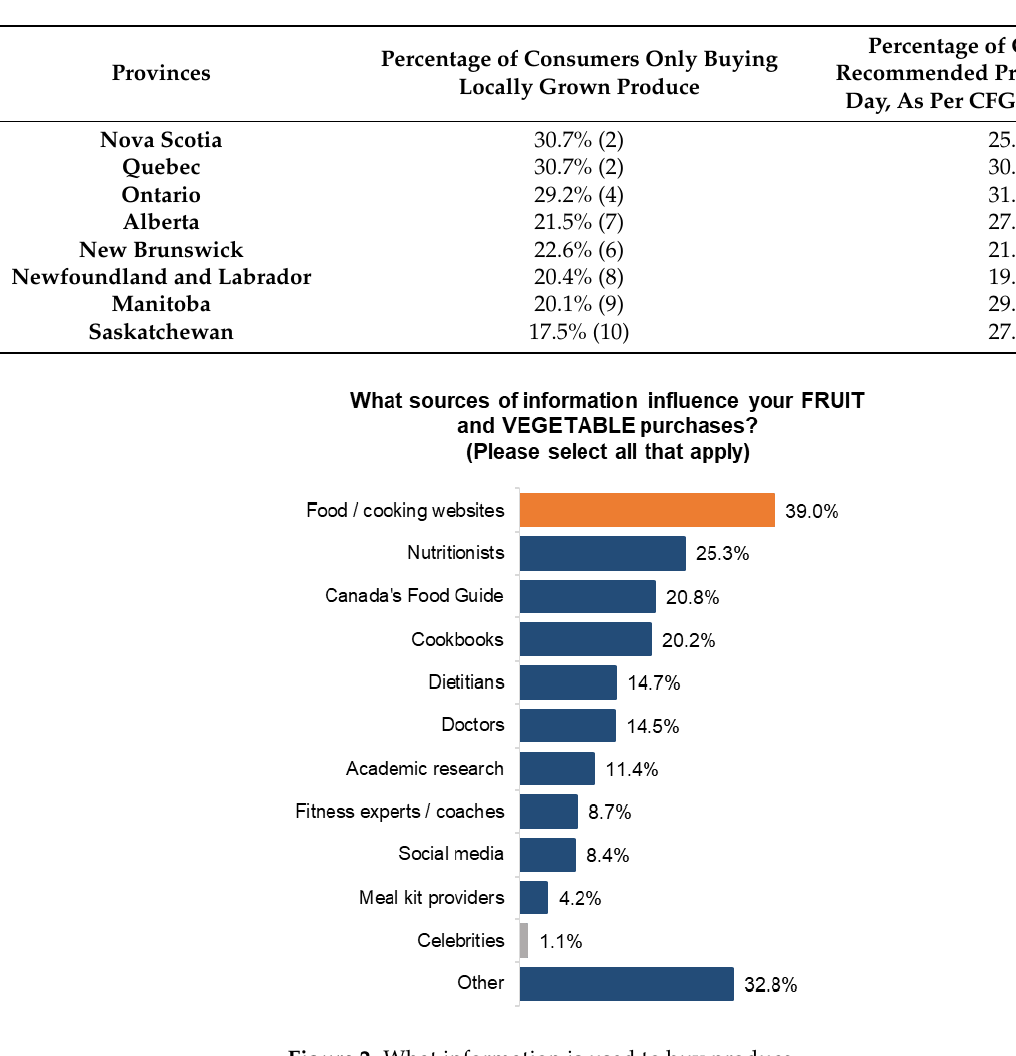
Figure 2. What information is used to buy